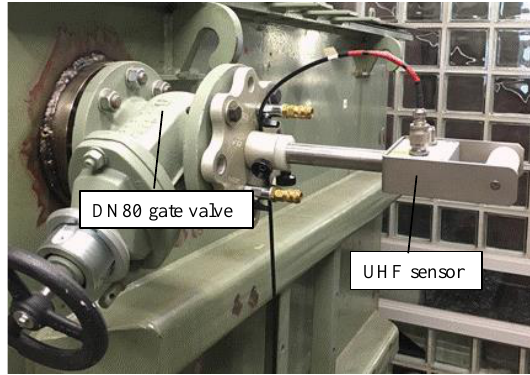
Figure 2. UHF drain valve sensor mounted with a DN80 gate valve.